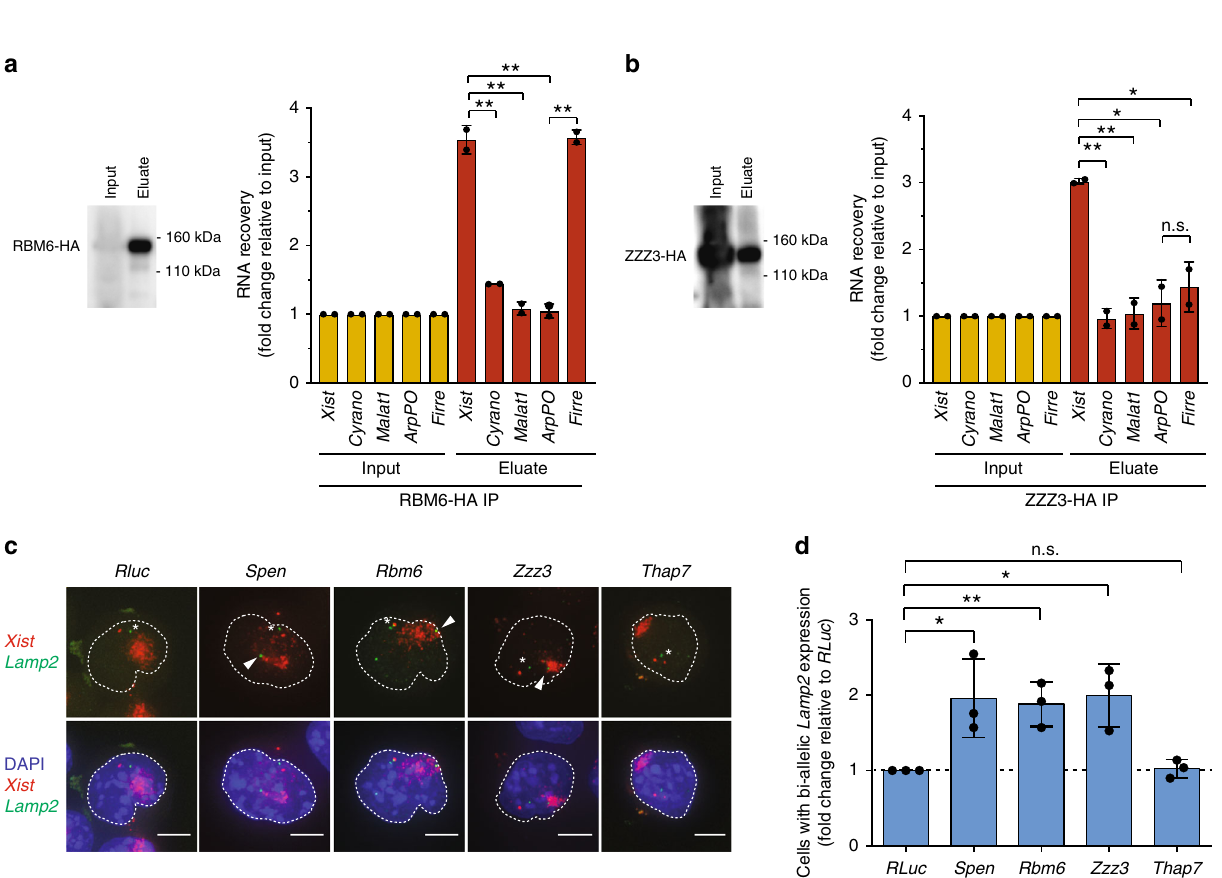
Fig. 5 RBM6 and ZZZ3 are required for XCI in vivo. a RNA immunoprecipitation (RIP) of the HA-tagged RBM6 protein. Left panel, western blot for RMB6. Right panel, RNA levels of the indicated transcripts in the input and in the immunoprecipitated eluates. All enrichments are normalized to GAPDH mRNA and to the input sample. Each RIP experiment was performed on two independent biological replicates. Data are presented as mean ± s.d.; unpaired t -tests: ** P < 0.01. b RNA immunoprecipitation (RIP) of the HA-tagged ZZZ3 protein. Left panel, western blot for ZZZ3. Right panel, RNA levels of the indicated transcripts in the input and in the immunoprecipitated eluates. All enrichments are normalized to GAPDH mRNA and to the input sample as described in the ‘ Methods ’ section. Each RIP experiment was performed twice on independent biological replicates. Data are presented as mean ± s.d.; unpaired t -tests: ** P < 0.01; * P < 0.05, not signi fi cant (ns). Full blots are provided as a Source Data fi le. c Representative RNA FISH images of Xist -induced cells upon depletion of the indicated proteins. Xist is shown in red and the X-linked gene Lamp2 in green. The dashed line delineates cell nuclei. Asterisks indicate Lamp2 expression from the active X chromosome. Arrowheads indicate Lamp2 expression from the inactive X chromosome that escapes XCI. Scale bars, 5 μ m. d Quanti fi cation of cells with bi-allelic Lamp2 expression assessed with RNA FISH and expressed as fold ratio over RLuc control. Data from three independent experiments are represented as mean ± s.d.; Student ’ s t -tests: ** P < 0.01; * P < 0.05; not signi fi cant (ns). Dashed line delineates the level of RLuc HA-tagged in the polymorphic TX1072 ES cell line that enables not with ZZZ3, thus con fi rming the Firre -RBM6 binding under doxycycline-induced Xist expression, triggering XCI in the endogenous conditions and further validating our incPRINT absence of differentiation 31,37 – 39 . RNA immunoprecipitation results (Fig. 5a, b). (RIP) after doxycycline induction of Xist and UV-cross-linking of Next, to test if RBM6 and ZZZ3 have an impact on XCI, we cells followed by qRT-PCR analyses identi fi ed a signi fi cant used single-cell RNA fl uorescent in situ hybridization (RNA enrichment of the Xist transcript with RBM6 and ZZZ3 proteins, FISH) to assess the expression of endogenous Lamp2 , an X-linked con fi rming their interaction in vivo (Fig. 5a, b). Notably, gene that is normally silenced during XCI initiation 40 . Upon incPRINT also identi fi ed RBM6 as interacting with Firre . RIP doxycycline-induced Xist expression, depletion of Rbm6 , Zzz3 , qRT-PCR detected a speci fi c interaction of Firre with RBM6 but and positive control Spen (Supplementary Fig. 4a, b) led to